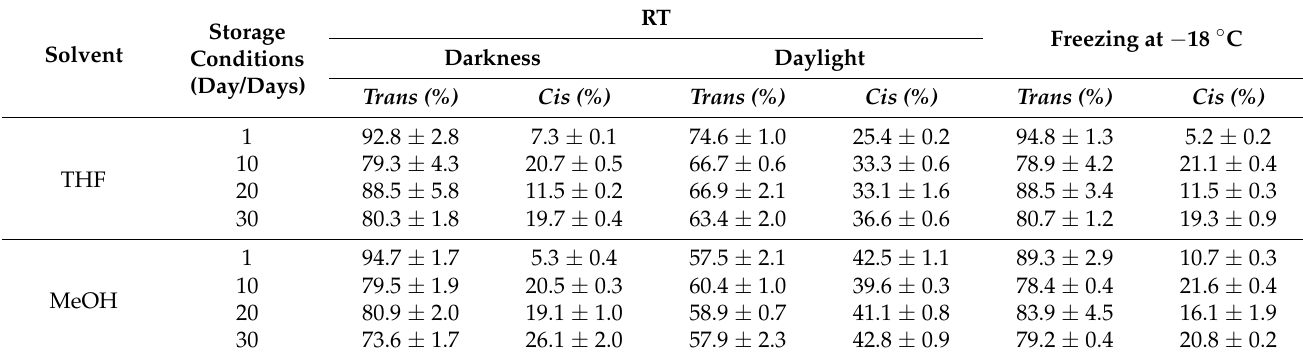
Table 2. Isomerization of trans -FA dissolved in THF or MeOH under the influence of different storage conditions.